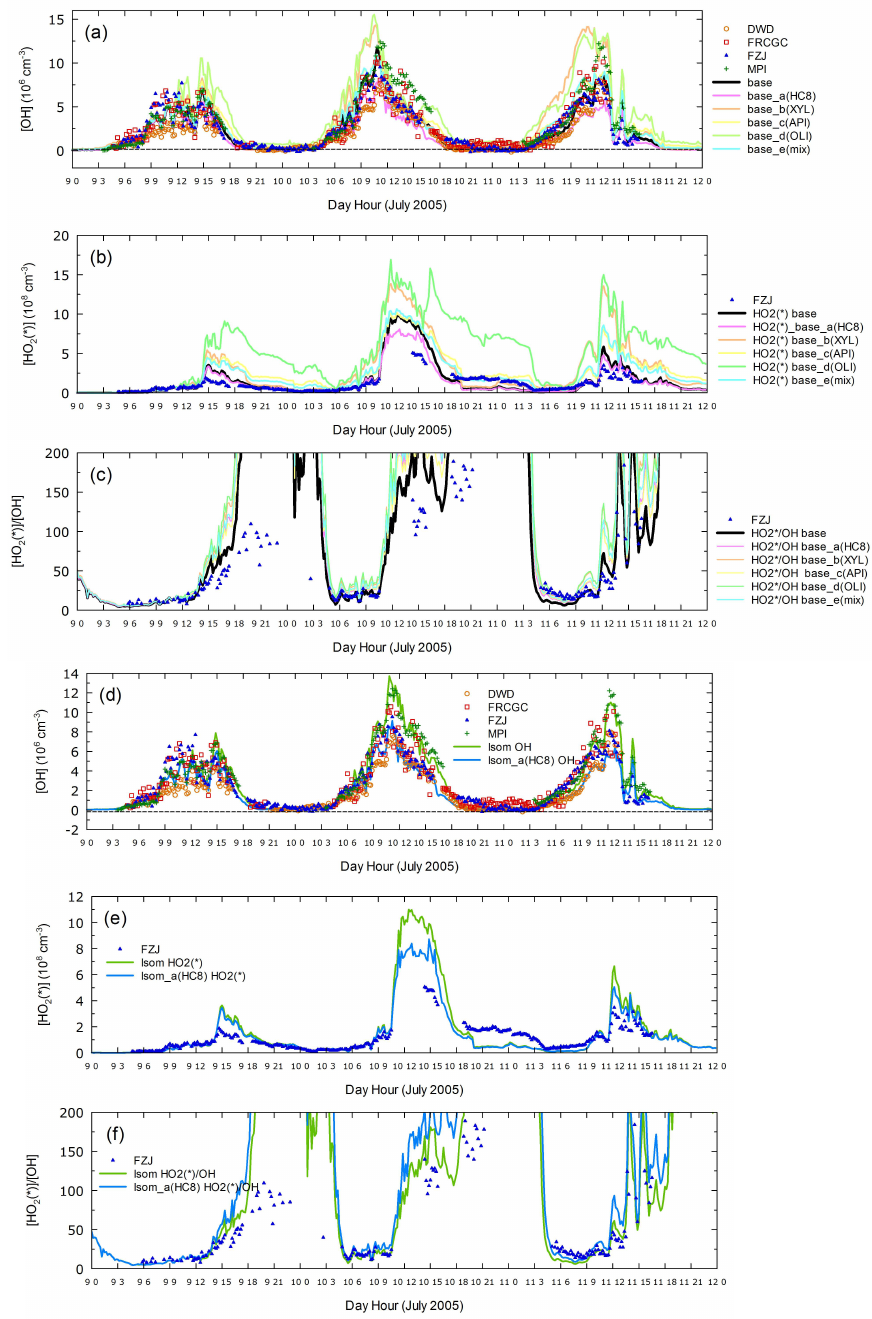
Fig. 6. Comparisons of observed and modeled (a) OH and (b) HO 2 (*) concentrations, and (c) HO 2 (*)/OH ratios. The results from the Base run and its variants (Base a(HC8), Base b(XYL), Base c(API), Base d(OLI), and Base e(mix)) are shown; (d) , (e) , and (f) are the same as (a–c) , but showing the results from the Isom and Isom a(HC8)